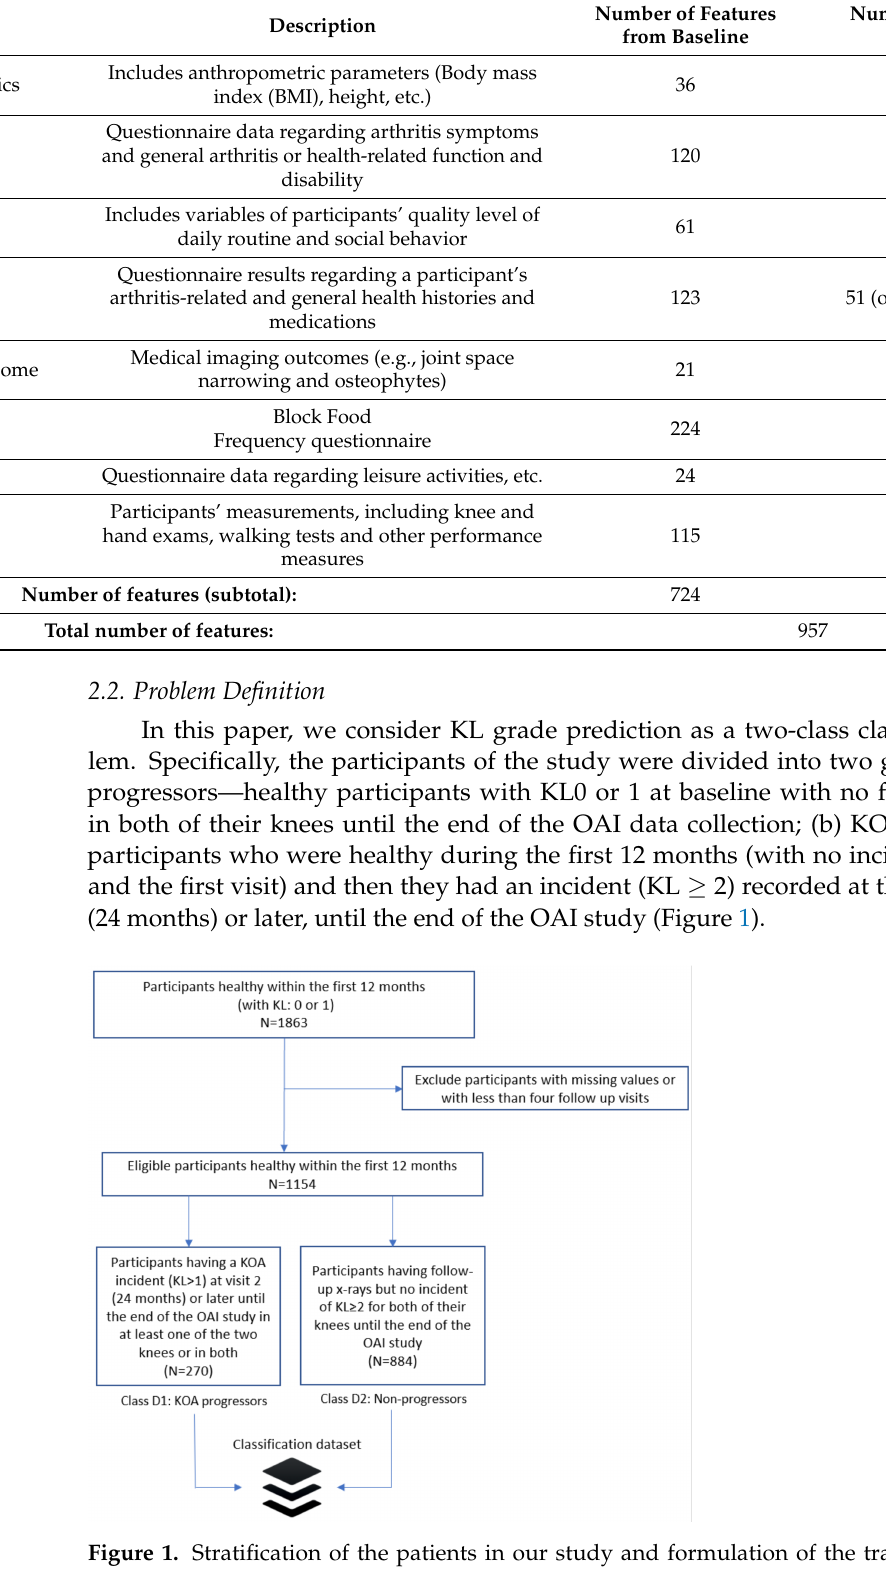
Figure 1. Stratification of the patients in our study and formulation of the training dataset. In- clusion/exclusion criteria are presented along with the definition of the two data classes (knee osteoarthritis (KOA) progressors and